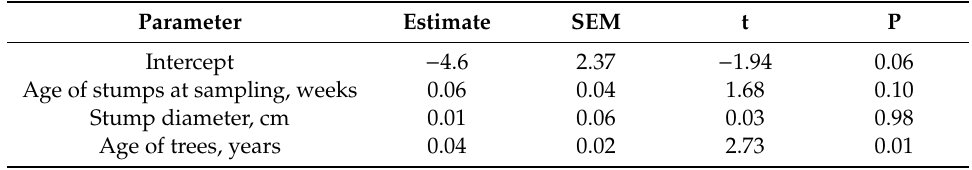
Table 5. Regression analysis summary for individual effects of parameters on area occupied by Phlebiopsis gigantea . r2 = 0.19; SEM, standard error of the mean.